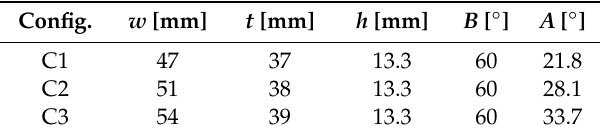
Table 2. Configurations and dimensions of the samples for the compression tests. Config.